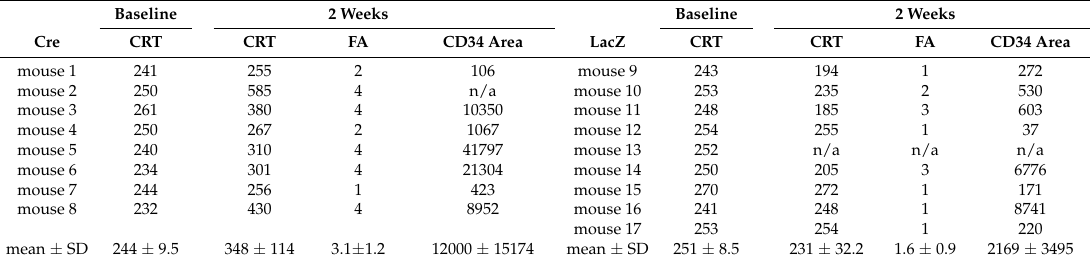
Table 1. Optical coherence tomography measured central retinal thickness (CRT) at baseline compared with CRT, fluorescein angiography (FA) stage of hyperfluorescence, and CD34 positive capillary area ( µ m 2 ) two weeks after injection. Baseline